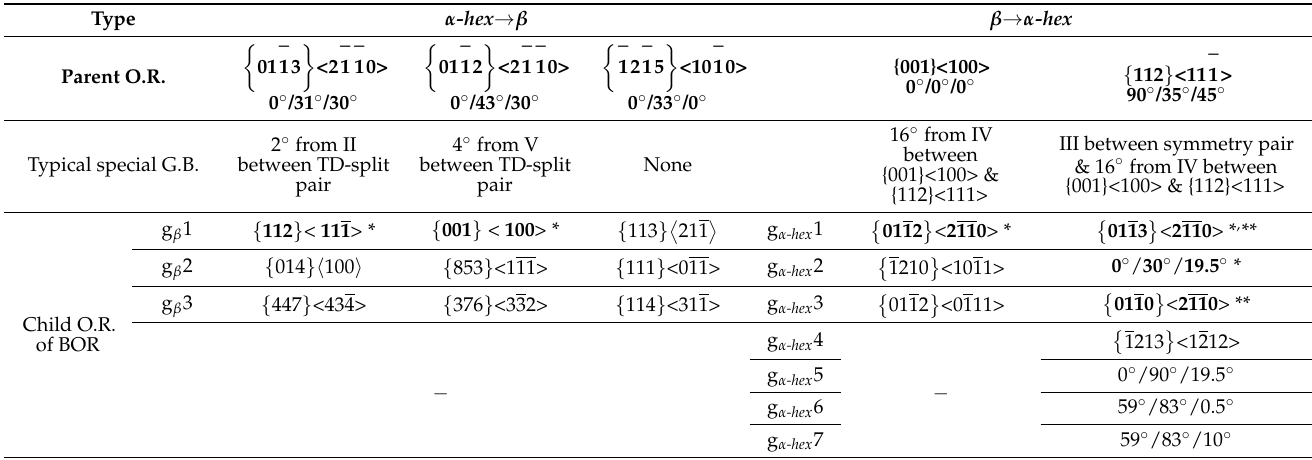
Figure 6. ( a – d ) ODF ϕ 2 = 45 ◦ sections for predictions of β textures ( a ) without and ( b – d ) with variant selection. The conditions of prediction in Figure 6a–d are indicated by arrows a-d in Figure 5, respectively. ( e ) and ( f – h ) ODF sections and pole figures for the optimum prediction by EDBOR n =2 shown in Figure 6d. Contour levels are ( a – d ) and ( f – h ) 1, 2, 3... and ( e ) 2, 4, 6..., respectively. Table 2. Orientations of major components in observed textures and their BOR and DBOR variants on the special boundaries. Three angles separated by slashes are Euler angles, ϕ 1 / Φ / ϕ 2 . Bold letters indicate DBOR variants, and ** and * indicate exact and near-DBOR variants on typical grain boundaries, respectively. Note that the number of BOR variants reduces to three or 7 by symmetry of parent